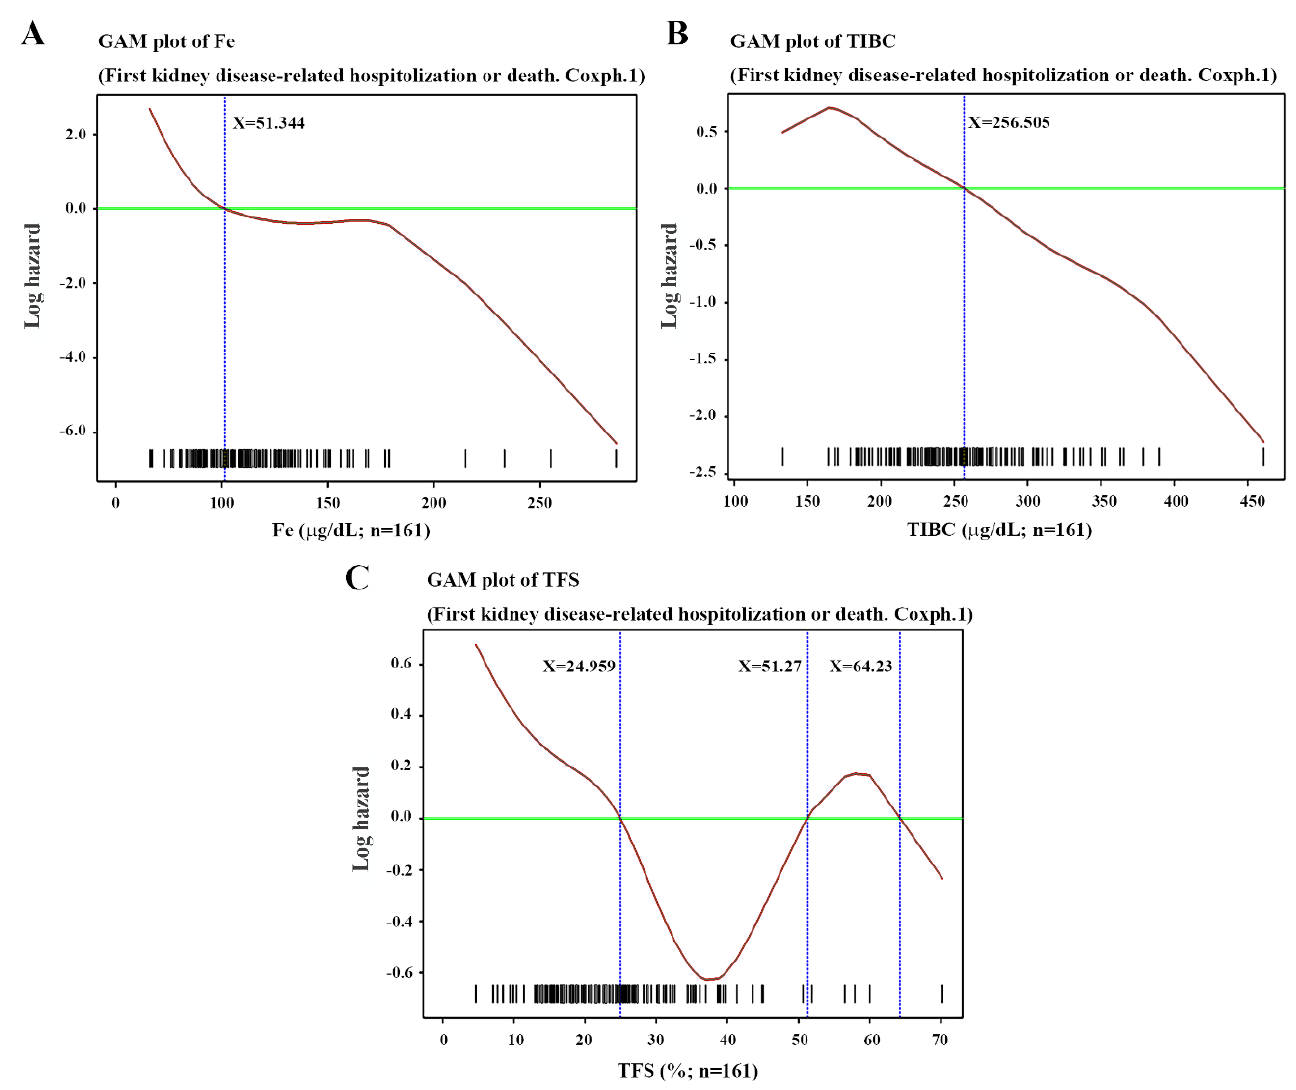
Figure 6. Generalized additive model (GAM) plots of time to first kidney disease − related hospitali- zation or death versus ( A ) serum iron (µg/dL); ( B ) total iron binding capacity (TIBC; µg/dL), TIBC level below 256.505 µg/dL having a poor outcome; and ( C ) transferrin saturation (TFS; %), TFS < 24.959% or >51.27% bringing high risk.